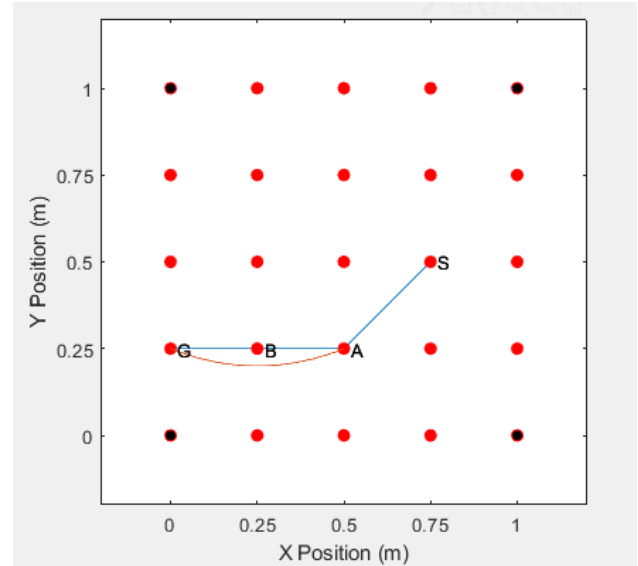
Figure 13. Simulation of Self-healing Capability with Shortcut.